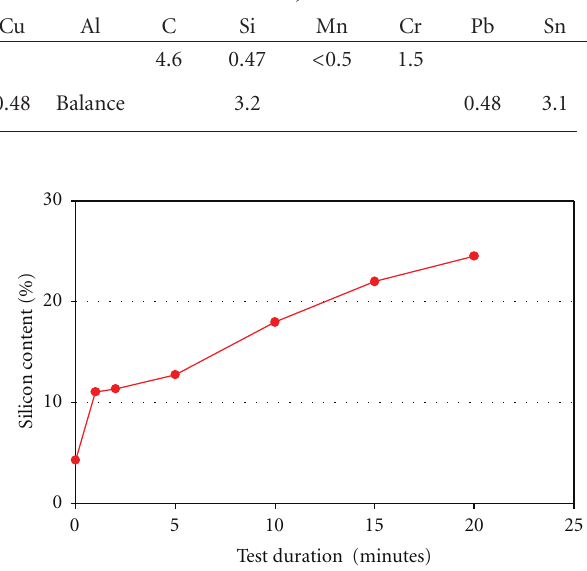
Figure 5: Wear on aluminium block after tribotest for 120 min.